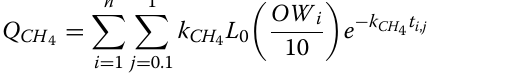
Table 2 Lower bound and upper bound of k CH 4 ( y −1 ) and L 0 ( m 3 CH